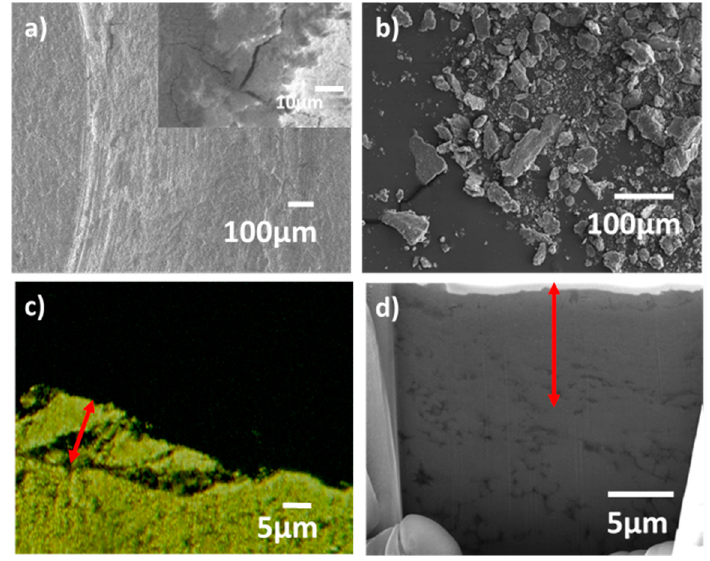
Figure 7. SEM images of the pure Al (RT): ( a ) wear track and ( b ) wear debris, ( c ) Optical micrograph of the sub-surface of the wear track, ( d ) FIB image of the sub-surface of the wear